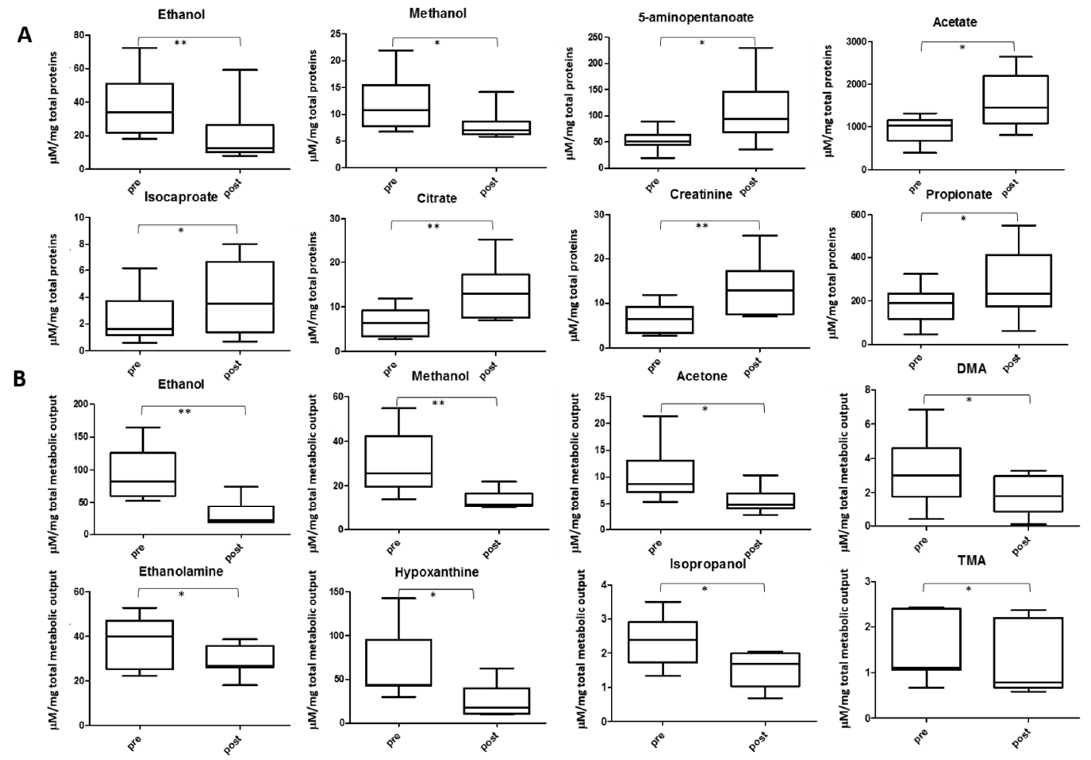
Figure 9. Other metabolites showing significant changes between pre- ( left ) and post-samples ( right ) when normalizing data by TPWS ( A ) or TOMC ( B ). In A metabolite concentrations are expressed as µ M / mg of total proteins, in B as µ M / total metabolic output. The boxes denote interquartile range, lines denotes median, whiskers denotes 5th and 95th percentile. * p < 0.05; ** p < 0.01.